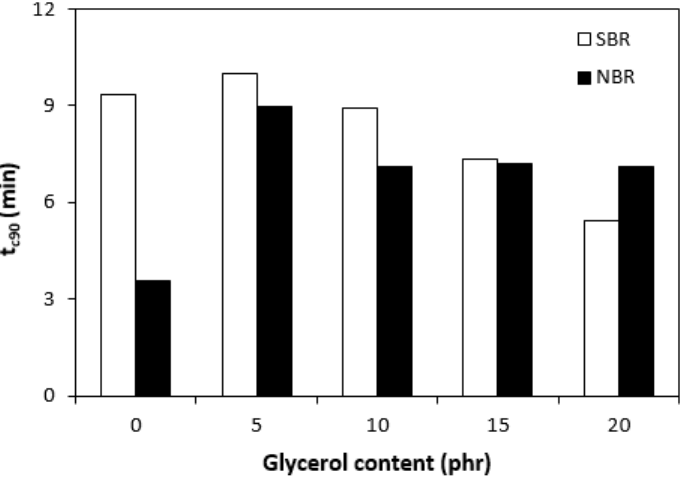
Figure 8. Influence of glycerol content on optimum cure time (t c90 ) of rubber compounds.